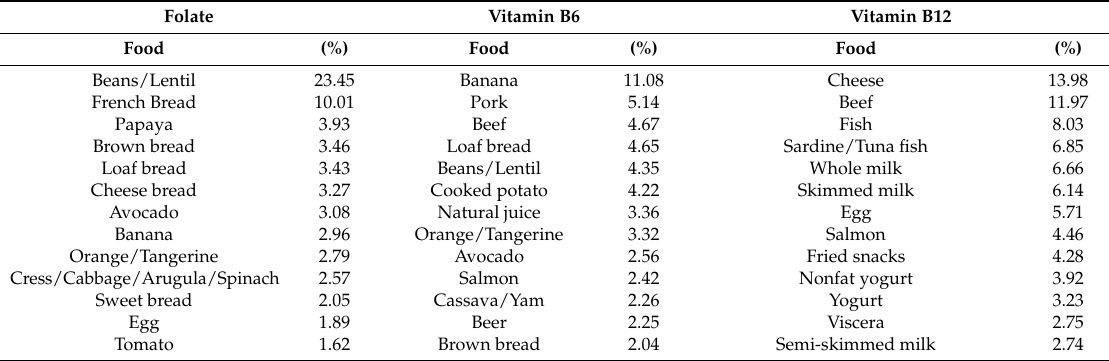
Table 2. Contribution (%) of food items to the dietary folate, vitamin B6, and vitamin B12 of the CUME project participants ( n =